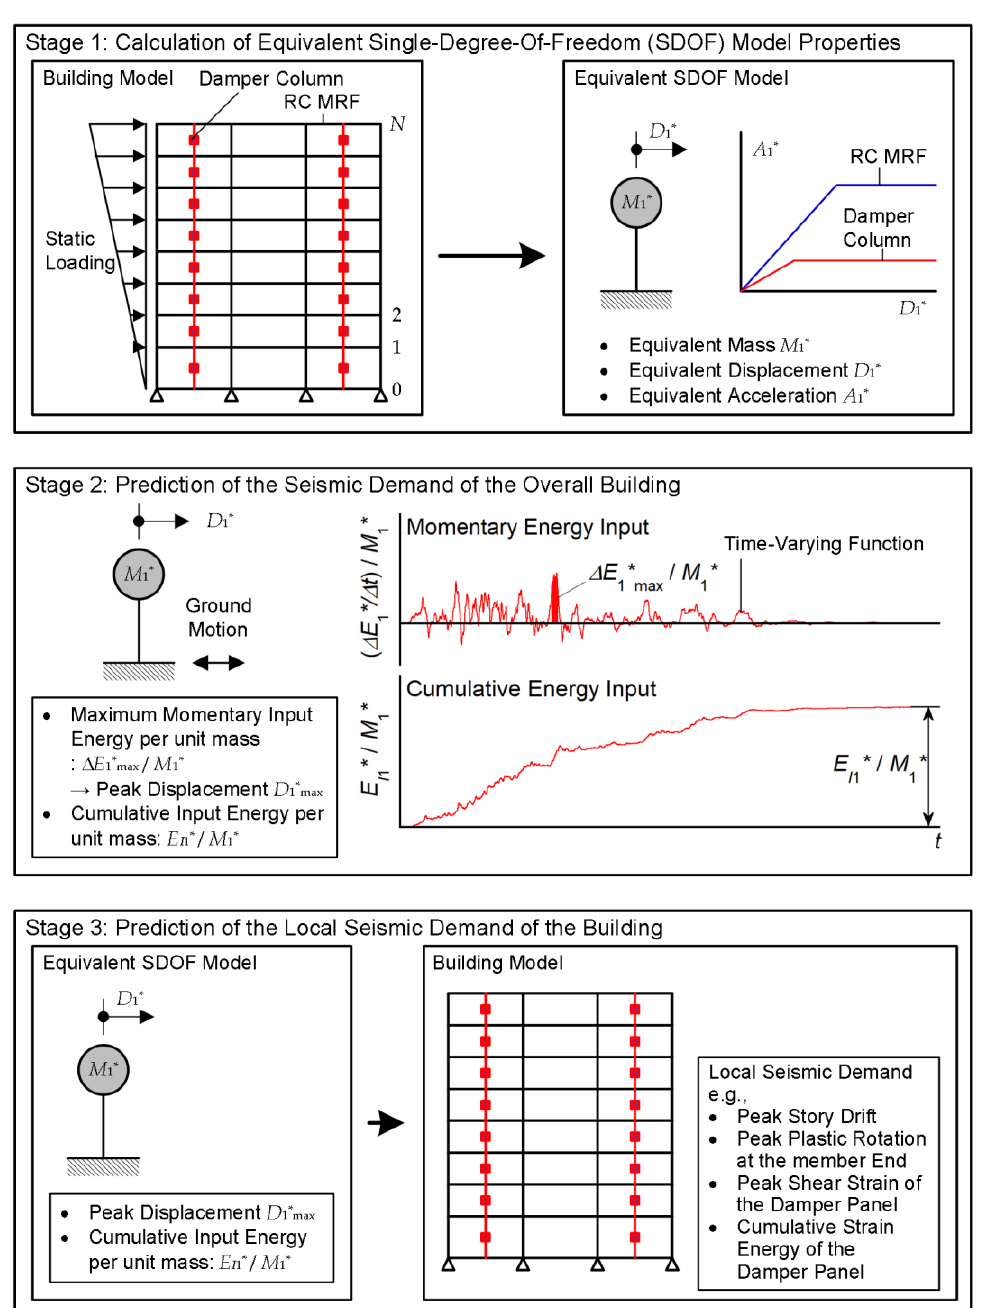
Figure 1. Outline of the proposed procedure.